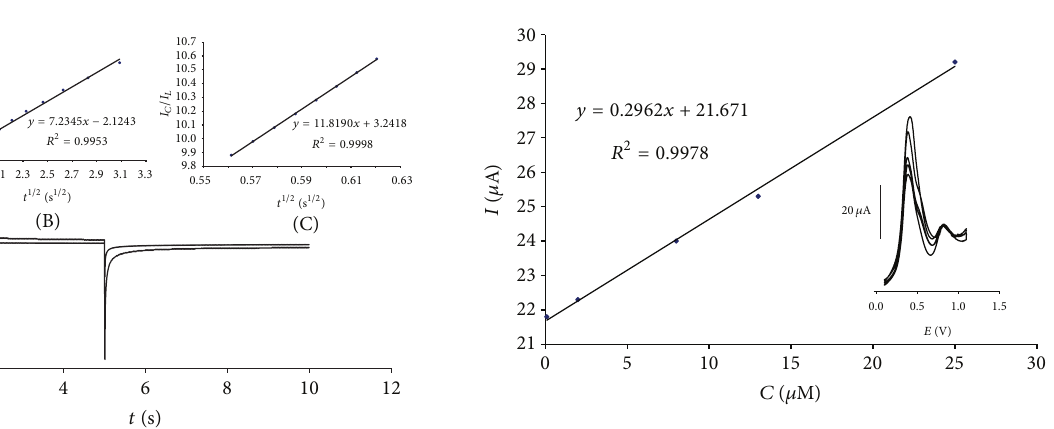
Figure 6: Plot of peak currents versus cysteamine concentration. Insert: square-wave voltammograms of cysteamine and tryptophan under the optimum conditions. 20.0 𝜇 M tryptophan with cys- teamine concentrations of (from inner to outer) (1) 0.1(2); 2.0; (3) 8.0; (4) 13.0; and (5) 25.0 𝜇